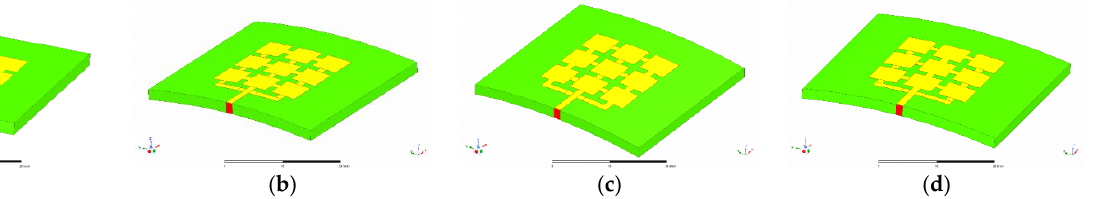
Figure 16. Four working conditions of reconfigurable microstrip antenna deformation measurement. ( a ) Working condition 0; ( b ) working condition 1; ( c ) working condition 2; ( d ) working con- dition 3. Table 14. Resonant frequencies of the Mode 1 antenna under four working conditions.